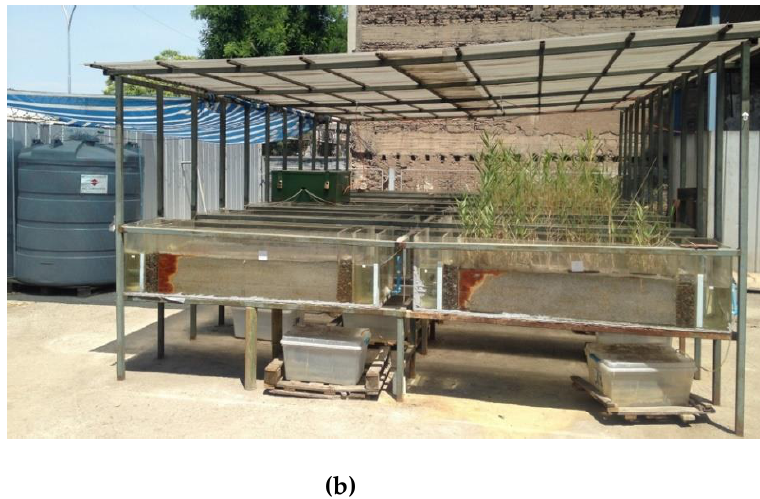
Figure 1. ( a ) Diagram of the cells. ( b ) Photograph of the wetland system. Table 1. Main characteristics of the synthetic water. Number of measurements = 13.